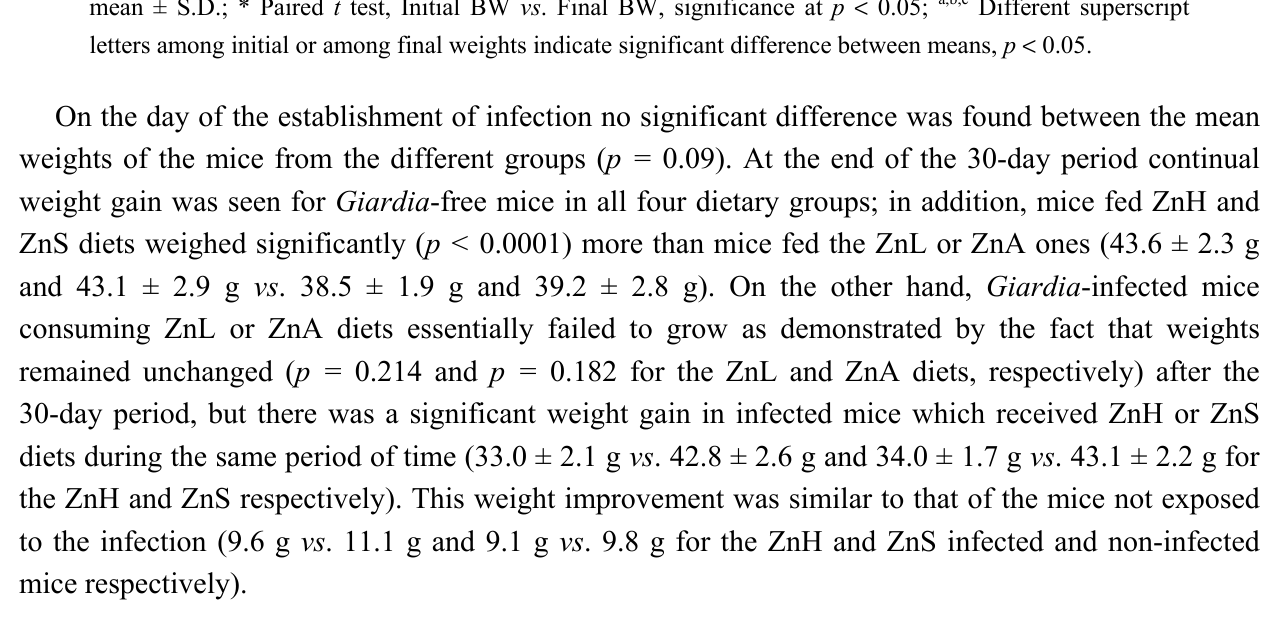
Table 2. The effect of dietary zinc and infection on body weight (BW) (g) at day 0 and 30 p.i. Giardia -free Giardia -infected Diet n Initial BW Final BW Gain p * n Initial BW Final BW Gain p * ZnL 9 34.9 ± 2.1 38.5 ± 1.9 b ZnH 10 32.5 ± 1.5 43.6 ± 2.6 c 11.1 < 0.001 10 33.0 ± 2.1 42.8 ± 2.6 c ZnS 8 33.3 ± 1.9 43.1 ± 2.9 c